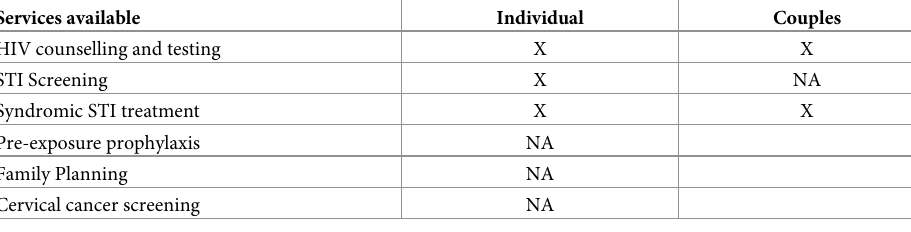
Table 1. Overview of the services offered at Bwaila VMMC